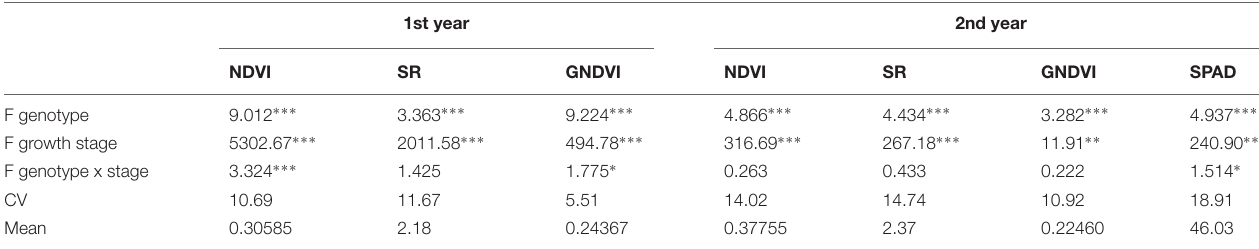
TABLE 4 | Analysis of Variance F -values for genotypes, growth stage, genotype × growth stage, Coefficient of Variation (CV) and means of NDVI, SR, GNDVI and SPAD